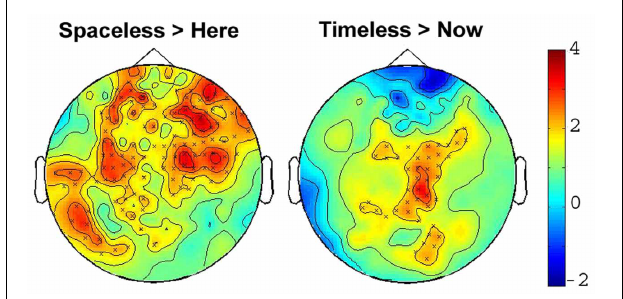
FIGURE 3 | 2D scalp maps of theta power SC contrasts. 2D topographic representations of significant sensor-level theta power (4–8Hz) SC for the Timelessness vs. Now ( Right ), and Spacelessness vs. Here ( Left ). Crosses on the map represent significant clusters; color bar scale indicates t